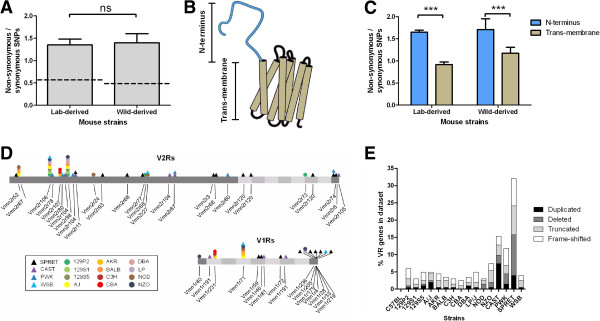
Evidence of dynamic selective pressures on VR repertoires in both laboratory- and wild-derived strains. (A) The ratio of non-synonymous to synonymous SNPs in VRs is similar between wild- and lab-derived strains (mean + SEM. Two-tailed t-test, P = 0.622), but higher than the genome averages (dashed lines: lab-derived = 0.54, wild-derived = 0.49 calculated from the data in [42]). (B) A schematic representation of the proposed secondary structure of a V2R receptor protein. The N-terminal domain (blue) is likely to be extracellular allowing it to interact with its pheromone ligand. (C) The normalised distribution of SNPs reveals significantly more functional variation is found in the N-terminal domains of V2Rs than trans-membrane domains (Two-way ANOVA, variance in domain F1,14 = 138, P < 0.0001, variance in strain F1,14 = 1.5, P = 0.24. Bonferroni post hoc test, *** = P < 0.001). (D) The distribution of termination codons across VRs. The VR domains are indicated by shading (N- and C-termini in dark grey, trans-membrane domains in lighter greys). The relative positions of the termination codon found in each gene are indicated beneath. The strain each termination codon is found in is indicated by colour and shape (lab-derived strains by circles, wild-derived strained by triangles), above. Note some termination codons are found in multiple strains and some genes have multiple termination codons (e.g. Vmn2r120). (E) The proportion of genes analysed with evidence of truncation, frame shift, deletion or duplication, suggesting the functional VR repertoire is highly variable between strains of mice. Any gene that contained more than one of these (for example, was truncated and had a deletion) was counted only once in the following order: duplication, deletion, truncation, frame shift.